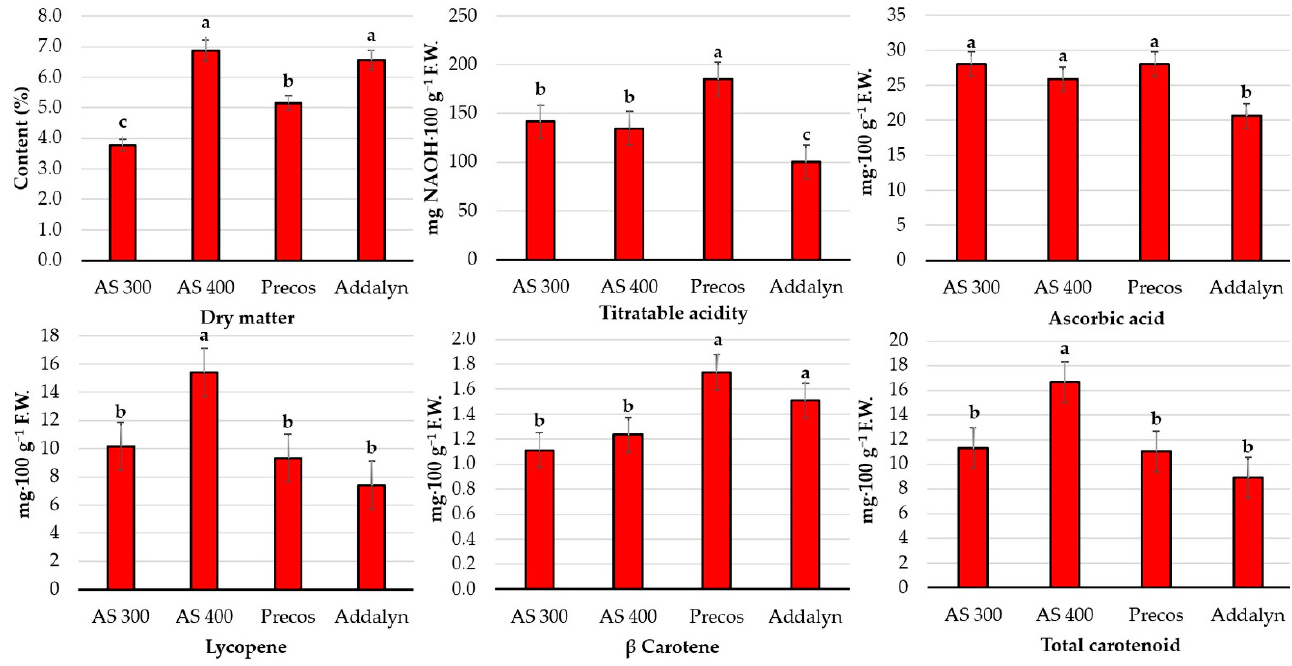
Figure 4. The main antioxidant compounds in tomato fruits depending on the genotypes analyzed. Values are expressed as mean ± SEM. For each trait, any two means followed by the same letter are not significantly different (Duncan’s test, α < 0.05). not significantly different (Duncan’s test, α <